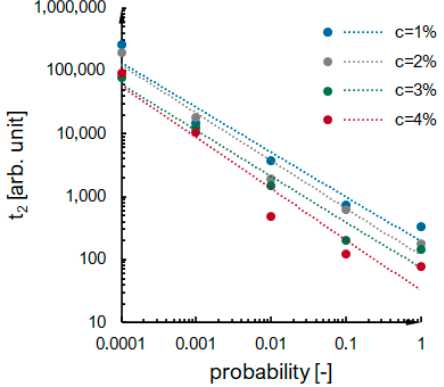
Figure 10. Dependence of dm/dt on time of reaction for syntheses A–F.